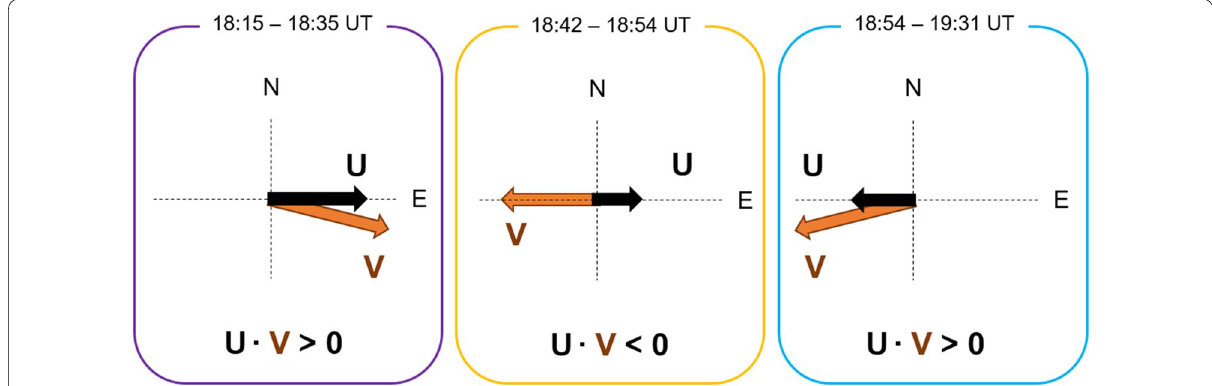
Fig. 6 Schematic drawing of the ion velocity (orange) and neutral wind (black) vectors for the three time intervals selected in Fig. 3 (purple: 18:15–18:35 UT; yellow: 18:42–18:54 UT; light blue: 18:54–19:31